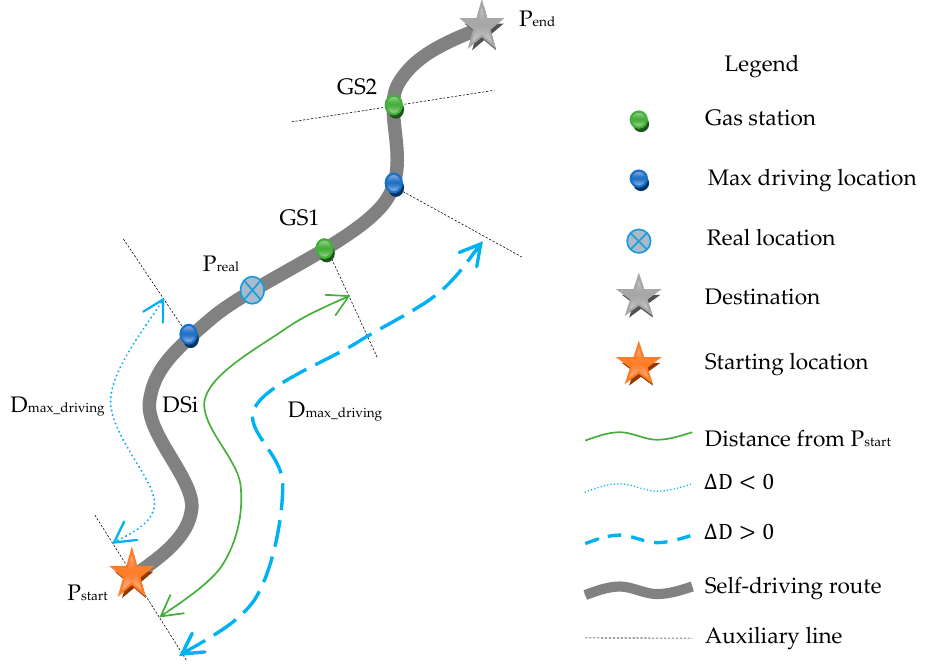
Figure 1. Diagram of the refueling recommendation problem. Table 1. Recommendation rules and strategies of refueling for self-driving travel.